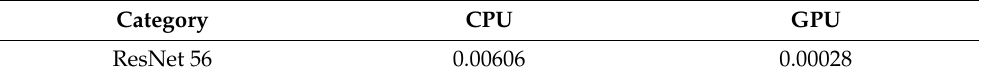
Table 5. CPU vs. GPU computational speed (Sec.) per image for each model in